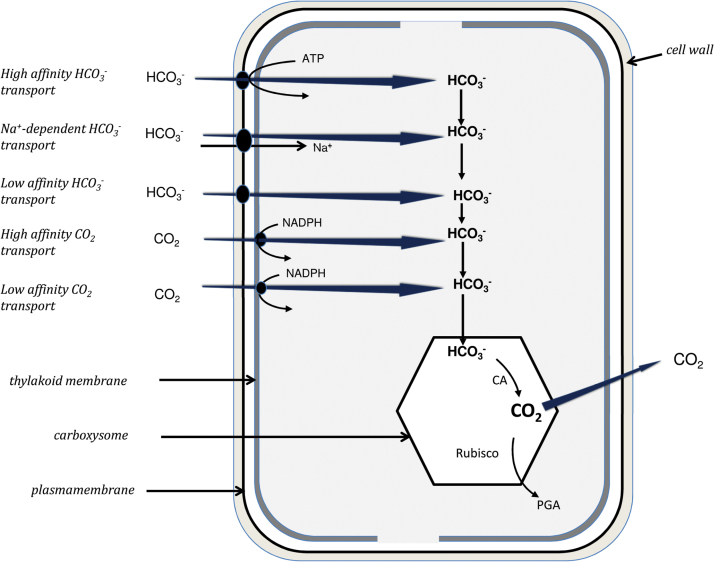
A schematic model for inorganic carbon transport, and CO2 accumulation and leakage in cyanobacteria. Low affinity transport systems are shown in grey and high affinity systems are shown in black, and are found at the plasmalemma and/or thylakoid membrane. Transporters whose characteristics are unknown are shown in white. Redrawn after Fig. 1 of Price et al. (2002), Badger and Price (2003), and Giordano et al. (2005). (Price et al. 2002. Modes of active inorganic carbon uptake in the cyanobacterium Synechocystis sp. PCC7942. Functional Plant Biology 29, 131–149. CSIRO PUBLISHING (http://www.publish.csiro.au/nid/102/paper/PP01229.htm). (Badger and Price 2003. CO2 concentrating mechanism in cyanobacteria: molecular components, their diversity and evolution. Journal of Experimental Botany 54, 609–622). (Giordano et al. 2005. CO2 concentrating mechanisms in algae: mechanisms, environmental modulation, and evolution. Annual Review of Plant Biology 6, 99–131).